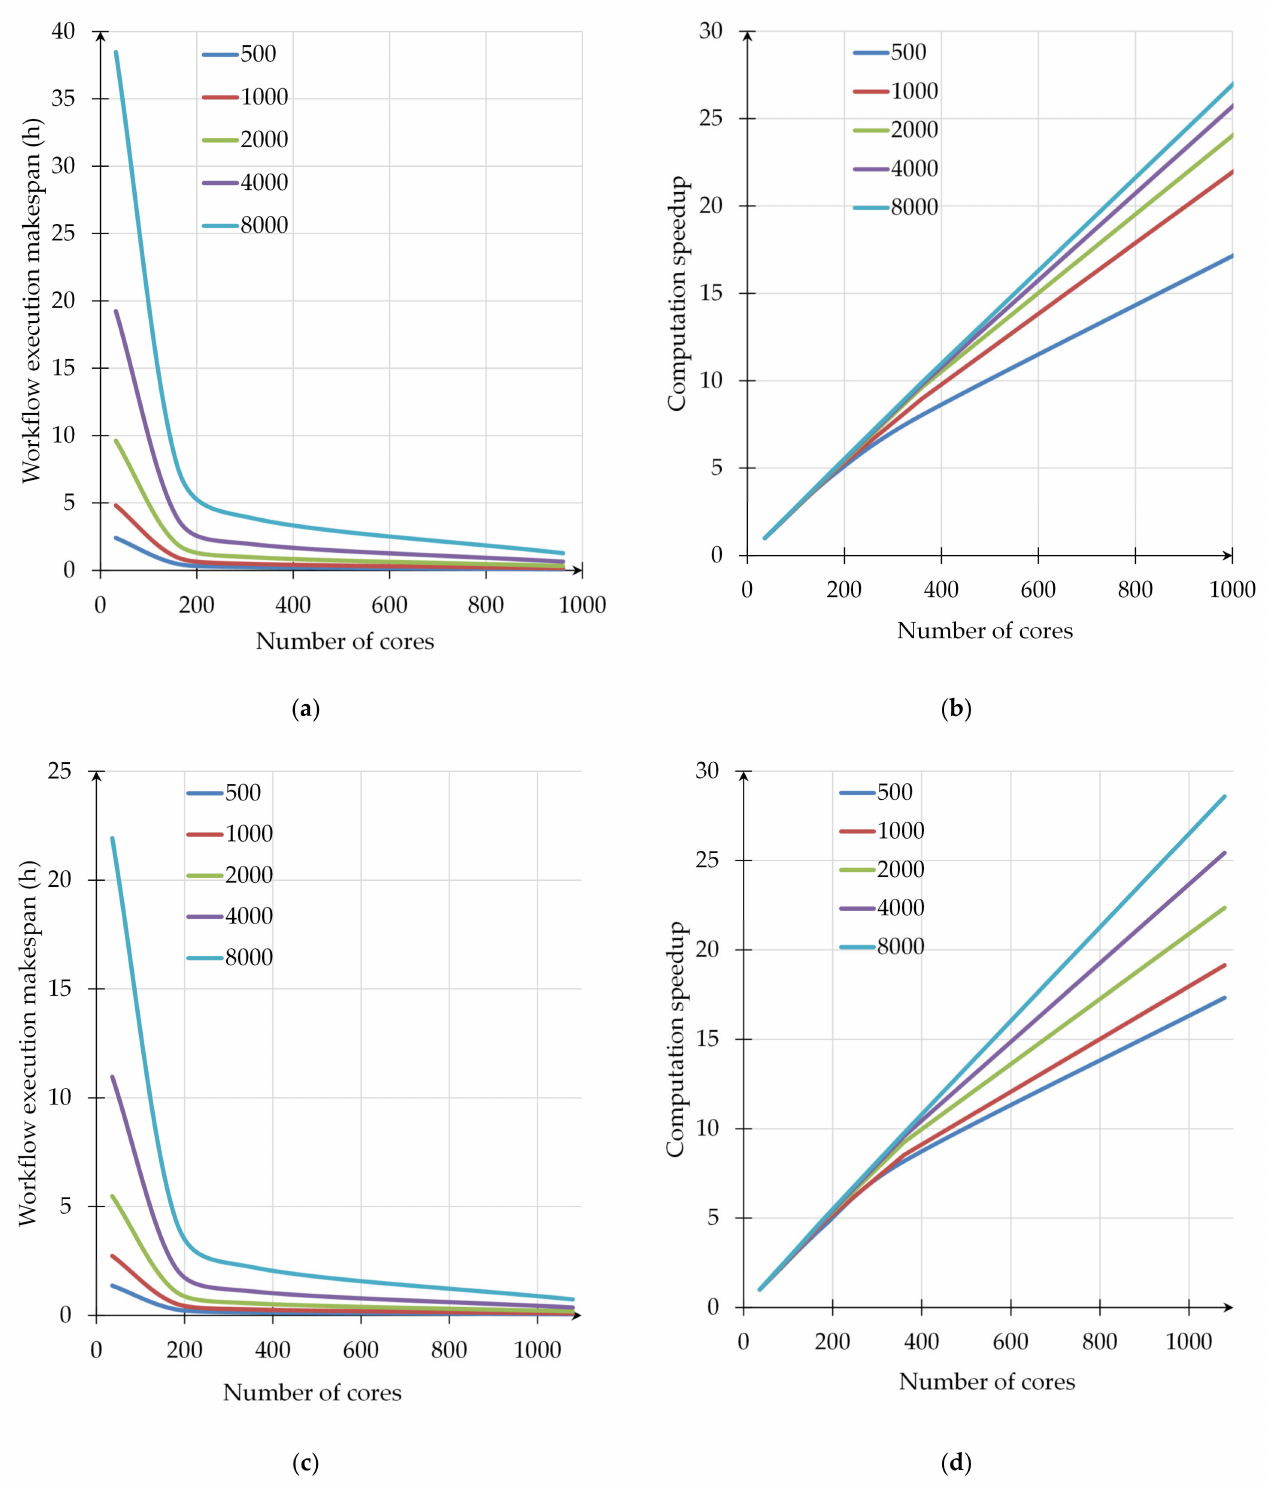
Figure 11. Workflow execution makespan ( a , c ) computation speedup ( b , d ) on the first cluster ( a , b ) and second cluster ( c , d ) obtained in adjusting the PF parameters using 500, 1000, 2000, 4000, and 8000